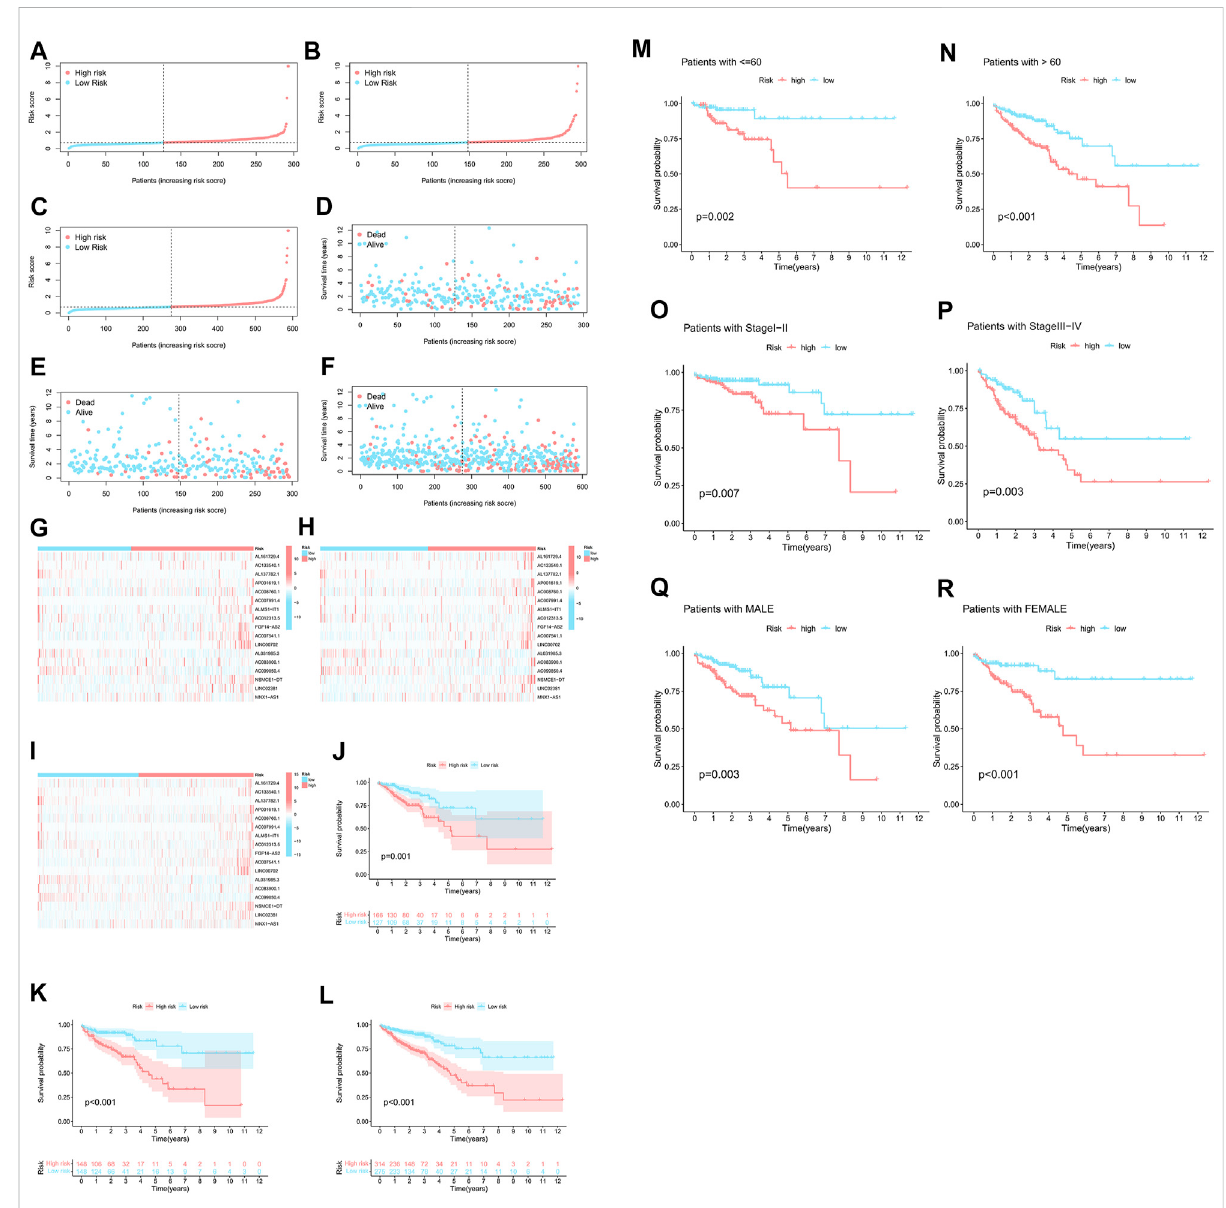
FIGURE 4 Ahighprognosticvalueispredictedforeachofthe17m7G-lncRNAs. (A – C) Displayofthem7G-relatedlncRNAsbasedontests,testresults,and thecompletesetofm7G-relatedlncRNAs. (D – F) Comparisonofthesurvivaltimesandsurvivalstatusinthetrain,test,andentiresets,respectively,for low- and high-risk groups. (G – I) The following is a heat map of the expression of 17 lncRNAs in the train set, test set, and entire sets. (J – L) For the train, test, and entire set sets of patients in low-risk and high-risk groups, respectively, Kaplan-Meier survival curves were generated for OS (survival probability). (M – R) Strati fi ed by age, gender, or stages, Kaplan-Meier survival curves show OS (survival probability) for low-risk and high-risk groups in the entire